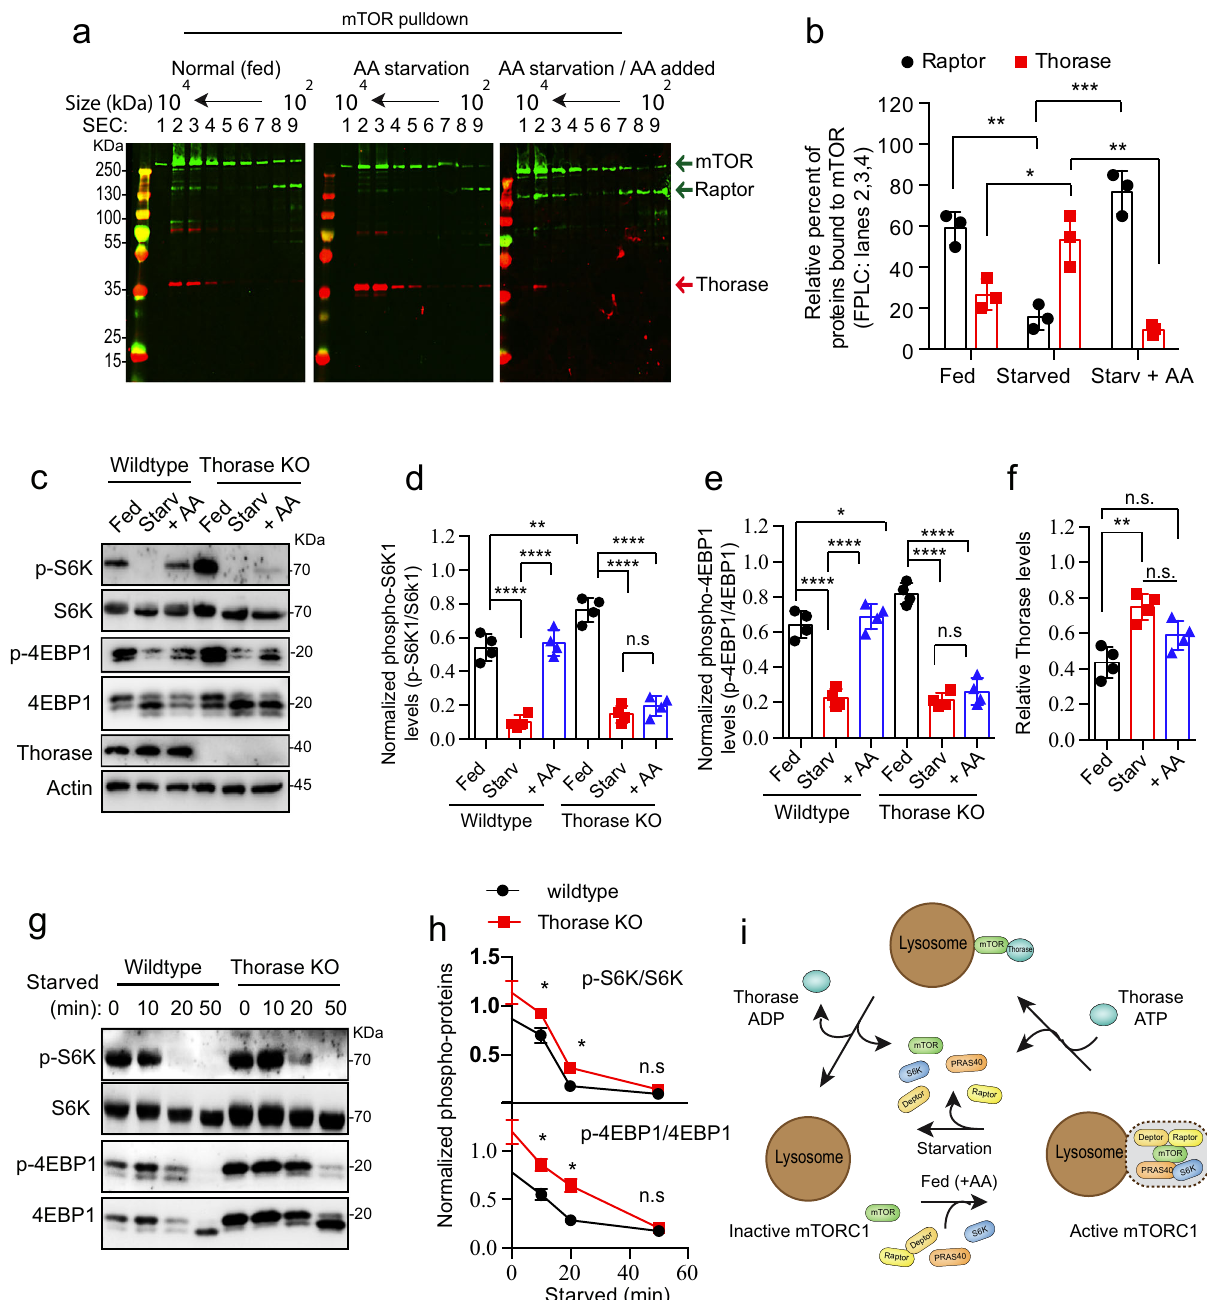
Fig. 6 | Amino acids stimulation of mTORC1 activation delay in the absence of Thorase. a Representative immunoblot images of mTOR IP (pulldown) protein complexes from WT MEFs under different nutrient status and protein com- plexes separated by SEC. b Quanti fi cation of blots in a ( n =3 independent pull downs). c Representative immunoblots of WT and KO MEFs showing mTORC1 activation (phosphorylation) status during amino acids (AA) starvation (Starv) and/or amino acid supplementation (+ AA). d – f Quanti fi cation of relative levels ofphospho-S6K( d ),phospho-4E-BP1( e ),andThorase( f )in c ( n =4independent experiments). g , h Representative immunoblots of WT and KO MEFs showing